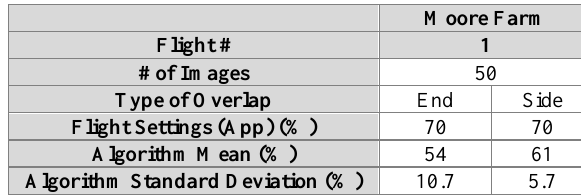
Table 4. Results from the Moore Farm